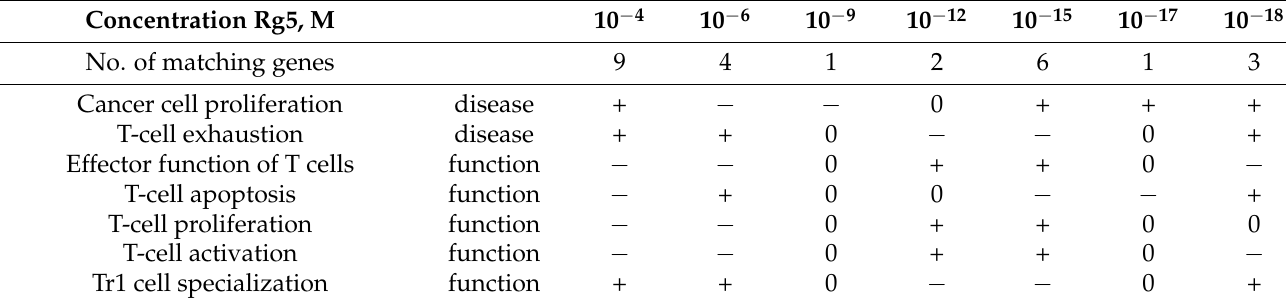
Table 8. The number of genes matching apoptosis receptor PD − 1 cancer immunotherapy signaling pathway and predicted effects of Rg5 in various diseases and cellular processes associated with cancer immunotherapy 1 . Concentration Rg5, M